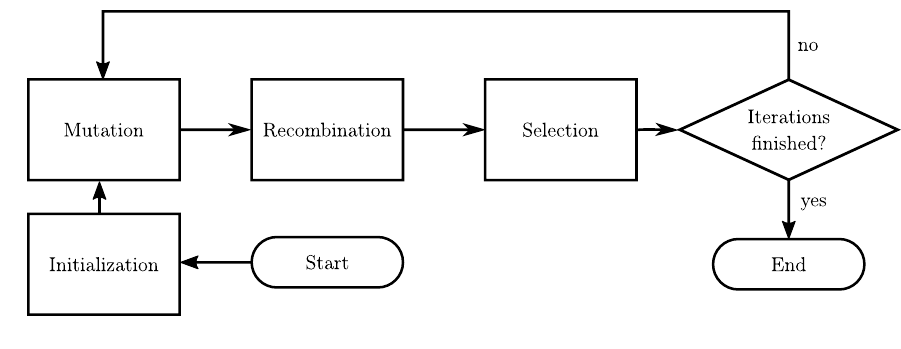
Figure 2. Differential Evolution